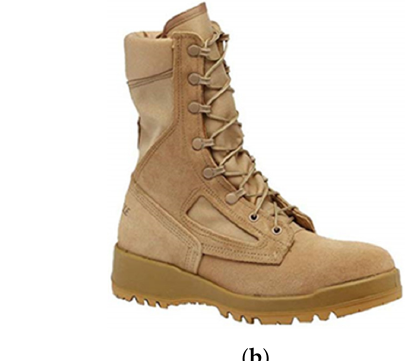
Table 1. Design characteristics of the two types of military footwear used in the study.